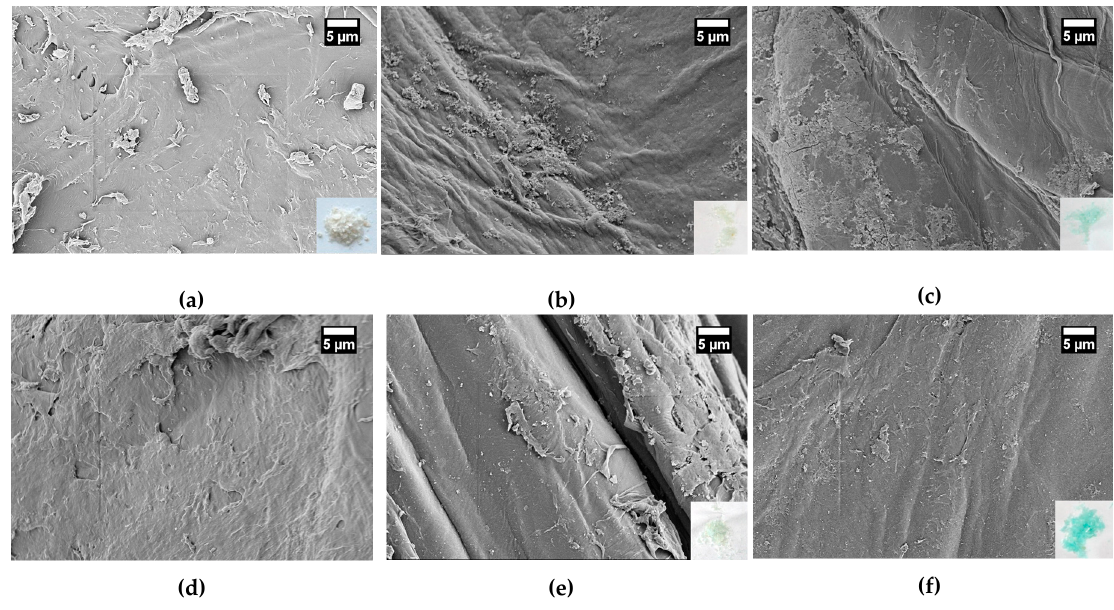
Figure 6. SEM images (magnification 2 kx) of chitosan surfaces ( a ) natural chitosan flake; ( b ) natural chitosan flake after the storage for 24 h in water and followed by air drying; ( c ) and ( d ) after adsorption of nickel ions from nickel nitrate solution with initial nickel ion concentration of ( c ) 35 mg · L − 1 Ni 2+ and ( d ) 350 mg · L − 1 Ni 2+ ; ( e ) and ( f ) after adsorption of nickel ions from nickel sulfate solution with initial nickel ion concentration with ( e ) 35 mg · L − 1 Ni 2+ and ( f ) 350 mg · L − 1 Ni 2+ . The contact time of chitosan with nickel solutions was 24